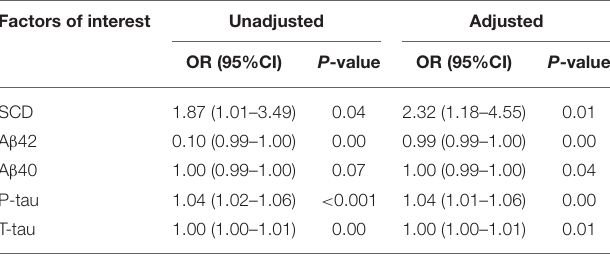
TABLE 3 | Analyze the influencing factors of POD and SCD by logistic regression.